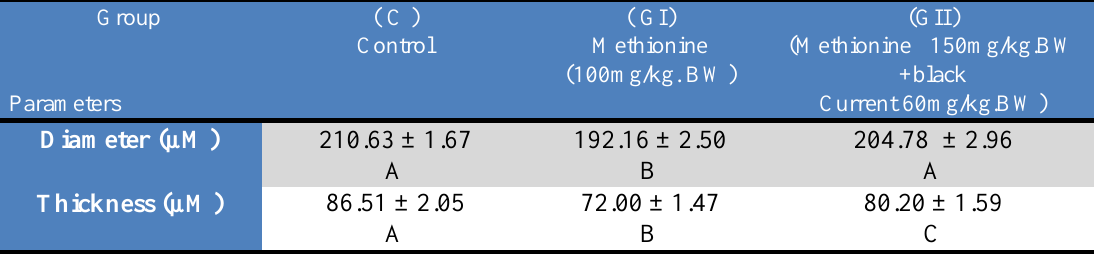
Values are expressed l as mean ± SE; n= 6 / group. Different capital letters denote between groups differences, P< 0.05 vs.